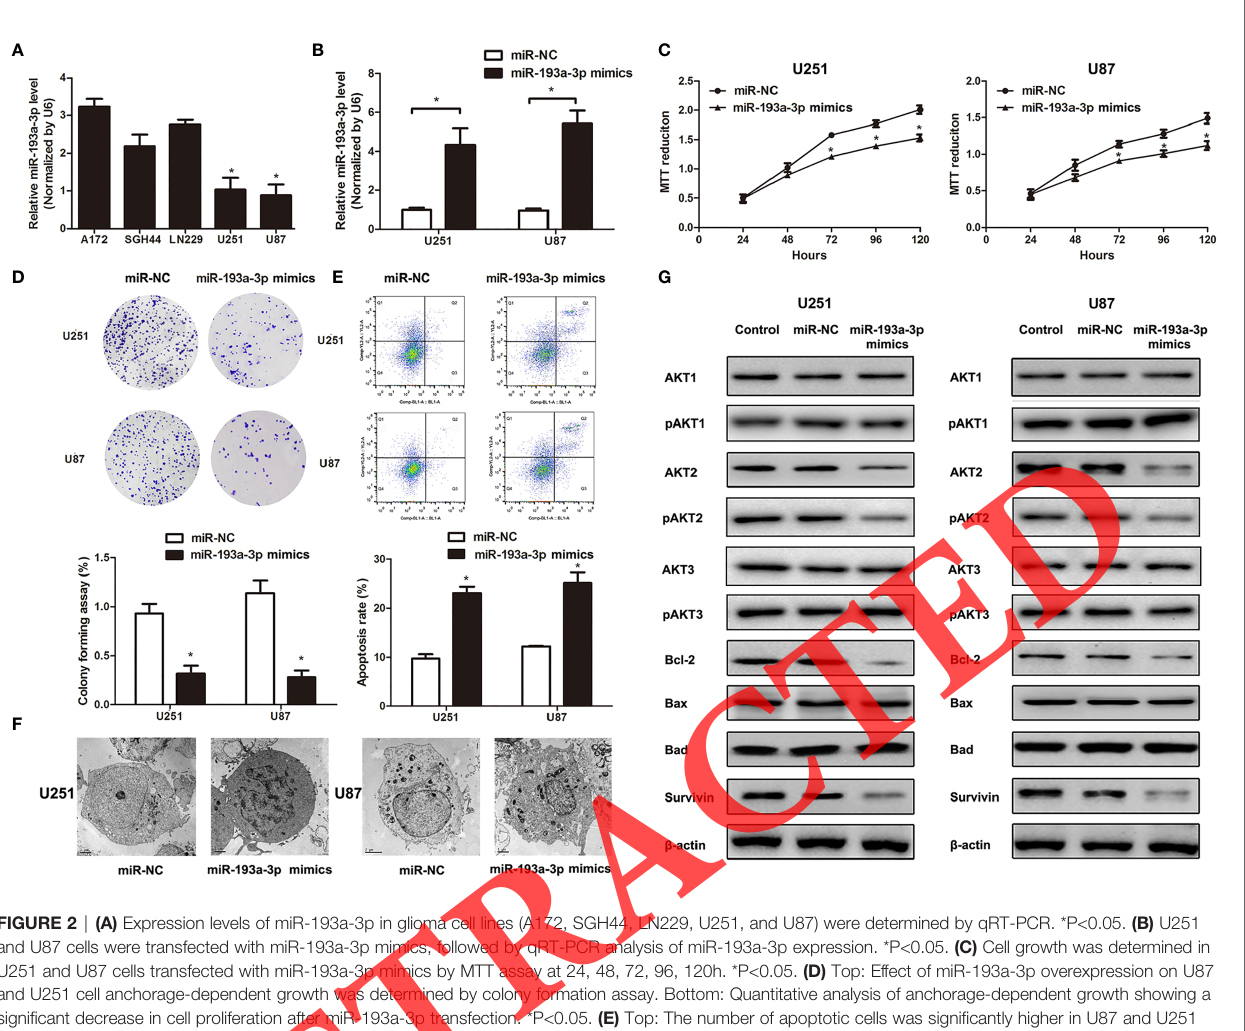
FIGURE 2 | (A) Expression levels of miR-193a-3p in glioma cell lines (A172, SGH44, LN229, U251, and U87) were determined by qRT-PCR. *P<0.05. (B) U251 and U87 cells were transfected with miR-193a-3p mimics, followed by qRT-PCR analysis of miR-193a-3p expression. *P<0.05. (C) Cell growth was determined in U251 and U87 cells transfected with miR-193a-3p mimics by MTT assay at 24, 48, 72, 96, 120h. *P<0.05. (D) Top: Effect of miR-193a-3p overexpression on U87 and U251 cell anchorage-dependent growth was determined by colony formation assay. Bottom: Quantitative analysis of anchorage-dependent growth showing a signi fi cant decrease in cell proliferation after miR-193a-3p transfection. *P<0.05. (E) Top: The number of apoptotic cells was signi fi cantly higher in U87 and U251 cells transfected with miR-193a-3p mimics as measured by PI staining and fl ow cytometry. Bottom: Quanti fi cation of scatter plots showing apoptotic cells as a percent of the total cell number examined by fl ow cytometry. *P<0.05. (F) The miR-193a-3p-transfected cells revealed typical apoptosis features, such as nuclear fragmentation, chromatin condensation and membrane blebbing. (G) Altered total AKT2, p-AKT2, Bcl-2 and Survivin are associated with overexpression of miR- 193a-3p, while no changes were observed in total AKT1, total AKT3, p-AKT1 and p-AKT3. Detection of AKT signaling molecules and apoptosis-associated proteins in U251 and U87 glioma cells by Western